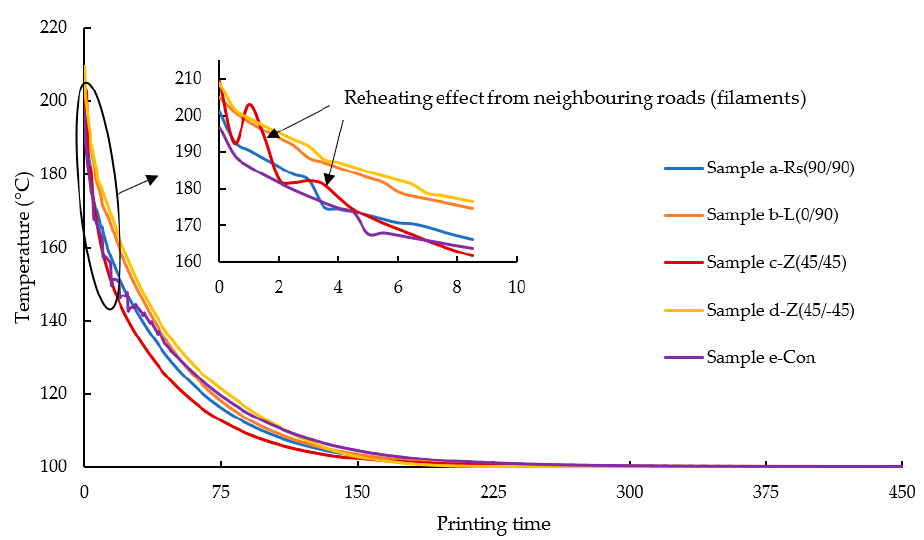
Figure 5. Comparison of thermal history of element m (selected from the top layer) from the models simulated under various raster pattern. An inset plot is attached to magnify the reheating effect received by element m from its neighbouring roads.